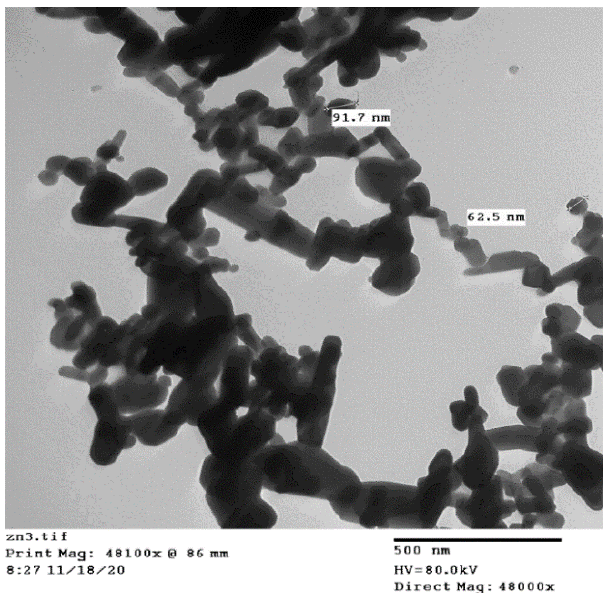
Figure 6. TEM image of synthesized zinc oxide nanoparticles